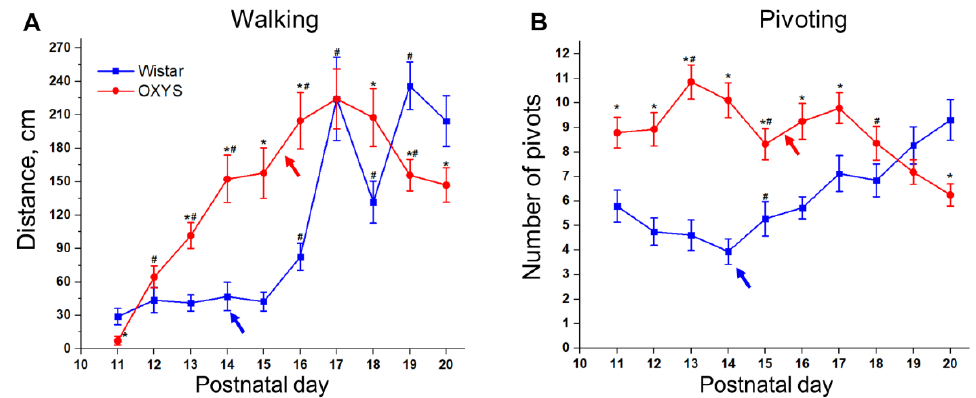
Figure 3. Locomotor activity of OXYS and Wistar pups. ( A ) The walking distance; ( B ) the number of pivots. * p < 0.05 as compared to control (Wistar) rats; # p < 0.05 as compared to a previous day; blue arrow: eye opening in Wistar pups; red arrow: eye opening in OXYS pups. The data are presented as the mean ± SEM.